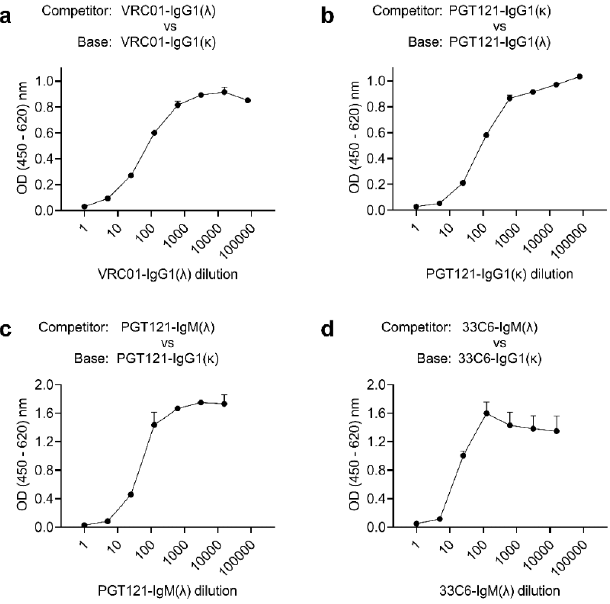
Figure 3. Competition ELISA to assess retention of epitope specificity after switching light chains (Methods): ( a ) testing whether VRC01-IgG1( λ ) can compete with VRC01-IgG1( κ ); ( b ) testing whether PGT121-IgG1( κ ) can compete with PGT121-IgG1( λ ); ( c ) testing whether PGT121-IgM( λ ) can compete with PGT121-IgG1( κ ); ( d ) testing whether 33C6-IgM( λ ) can compete with 33C6-IgG1( κ ). A dose– response curve is indicative of shared epitope specificity. Data are representative of two indepen- dent